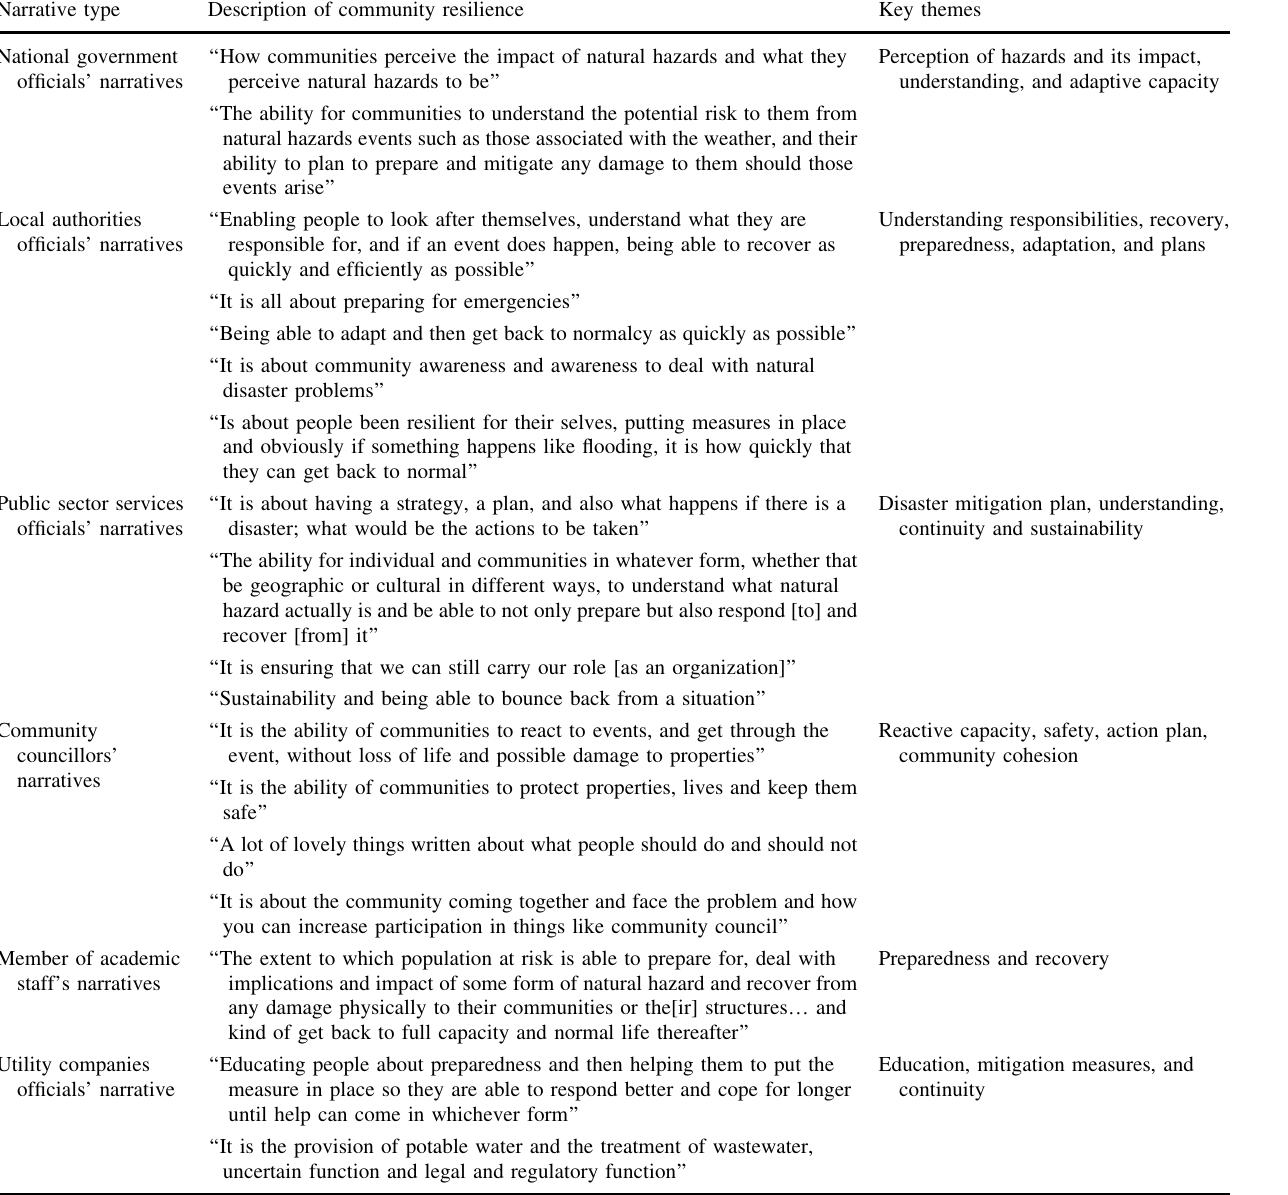
Table 4 Stakeholder descriptions of community resilience in Scotland’s Regional and Local Resilience Partnerships Narrative